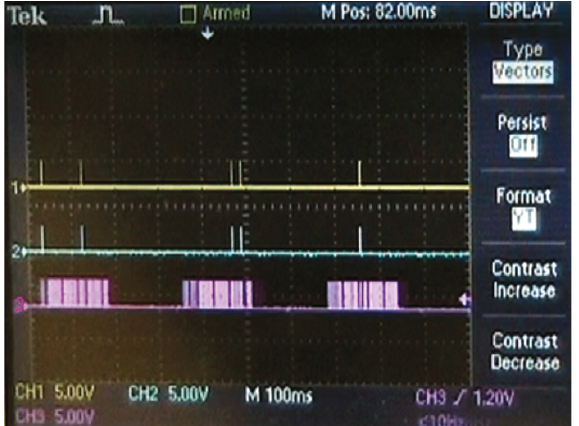
Figure 22: Implementation of WisperNet-Time showing changing patterns on a frame-by-frame